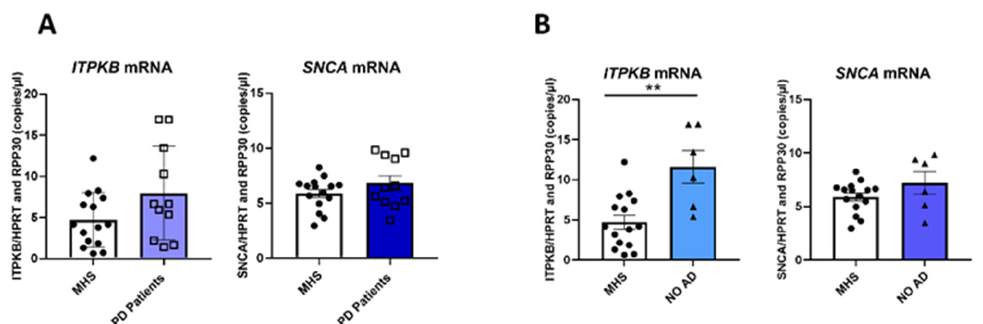
Figure 4. ITPKB and SNCA expression assessment in the cortex of PD patients and matched healthy controls. RNA was extracted from the cortex of 11 PD patients and 15 matched healthy subjects (MHS). ITPKB and SNCA mRNA levels were quantified using ddPCR. ( A ) Bar graphs show ITPKB (left) and SNCA (right) quantification in MHS and patients. ( B ) Patients who showed Alzheimer’s Disease co-morbidity were removed from the “PD patients’ group” (NO AD group). ITPKB (left) and SNCA (right) mRNA levels were compared with MHS. Mean ± s.e.m. (standard error of the mean) are shown. An unpaired two-tailed T -test with Welch’s correction was performed; ** p ≤ 0.01.